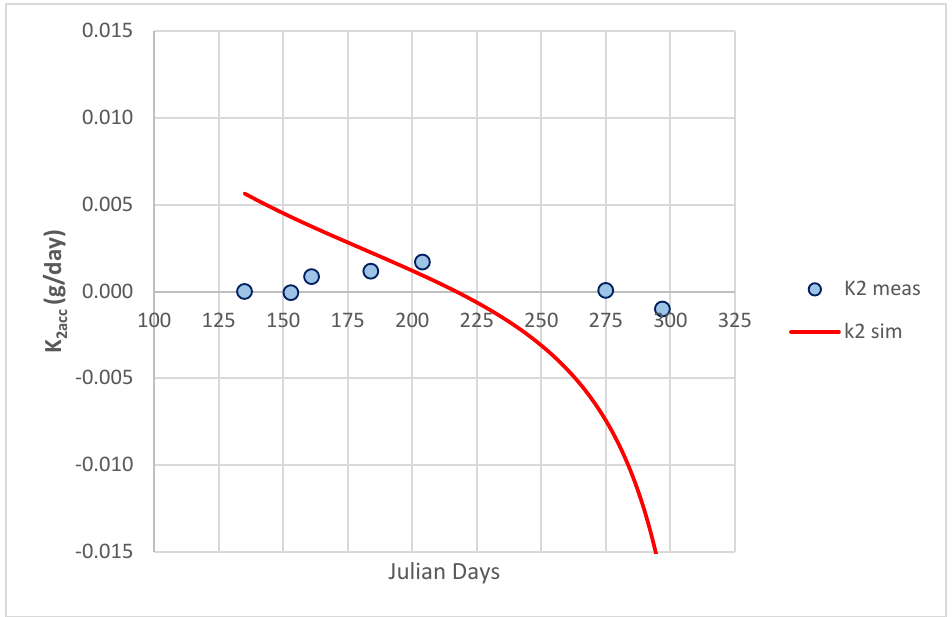
Figure 5. Simulated k 2acc (t) values obtained by Equation 10 (continuous line in red), and the observed ones obtained by Equation 8 (points in blue).